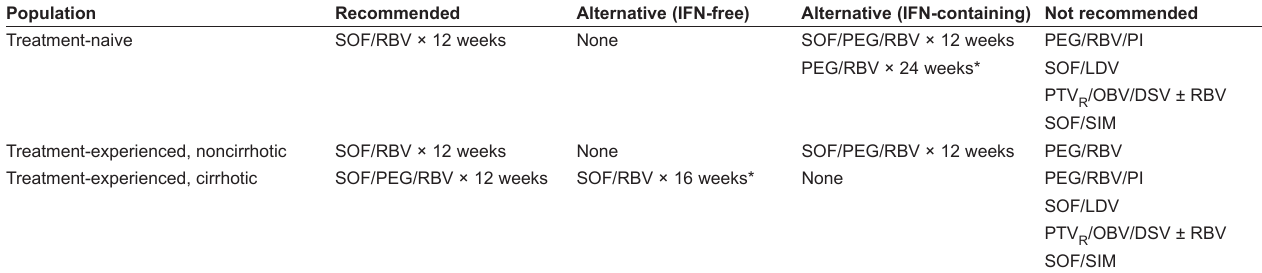
TABle 6 Patients with hepatitis C virus genotype 2